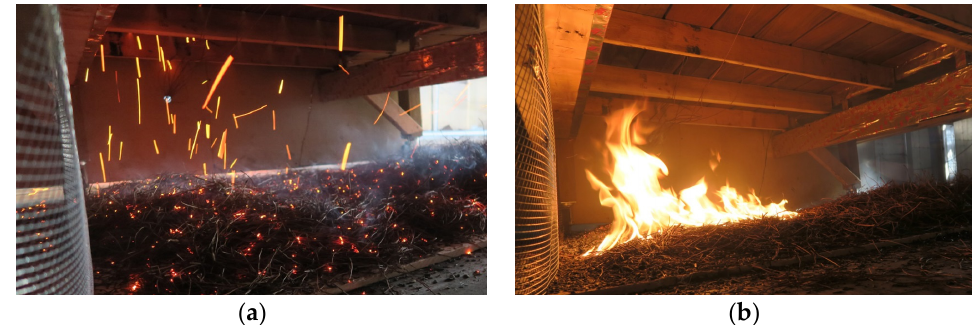
Figure 12. ( a ) Embers dropping between the boards gaps. ( b ) Embers igniting the pine needles and causing under ‐ deck flame impingement.